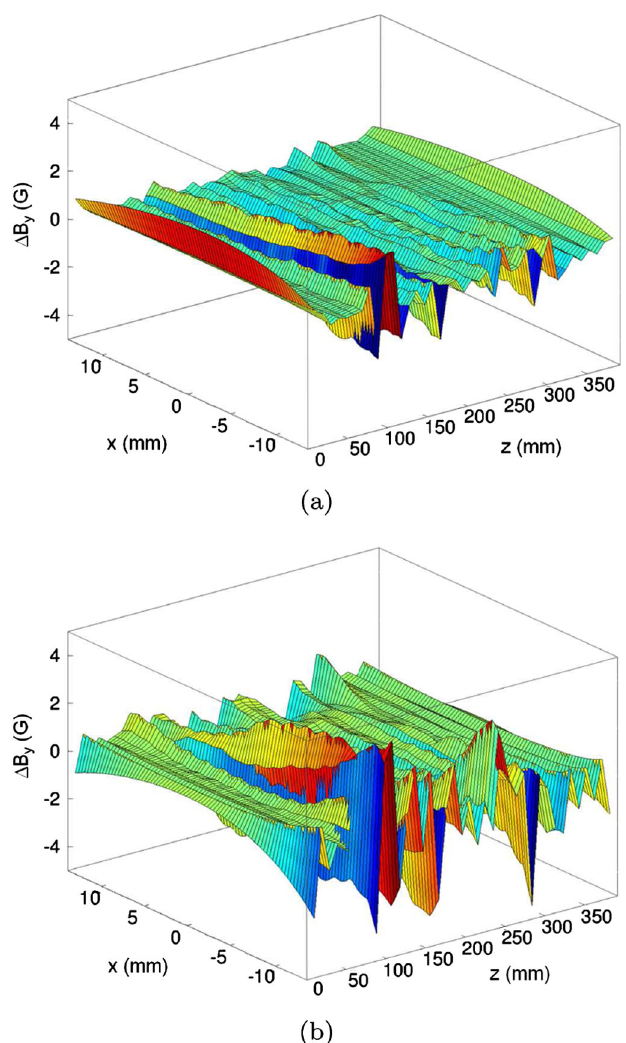
FIG. 3. Residuals of the fit to the field in a single EMMA cell (a) in the median plane, and (b) in the plane with coordinate y ¼ 10 mm . In both cases, the residuals increase with the horizontal excursion x (i.e. approaching the surface on which the fit is